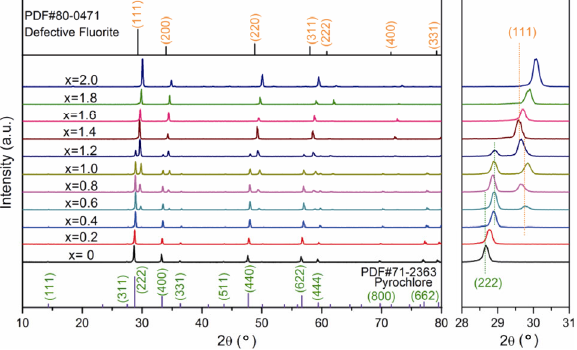
Fig. 19 XRD patterns of La 2– x Lu x Zr 2 O 7 ( x = 0–2.0) ceramics. Reproduced with permission from Ref. [49], © Elsevier Ltd.